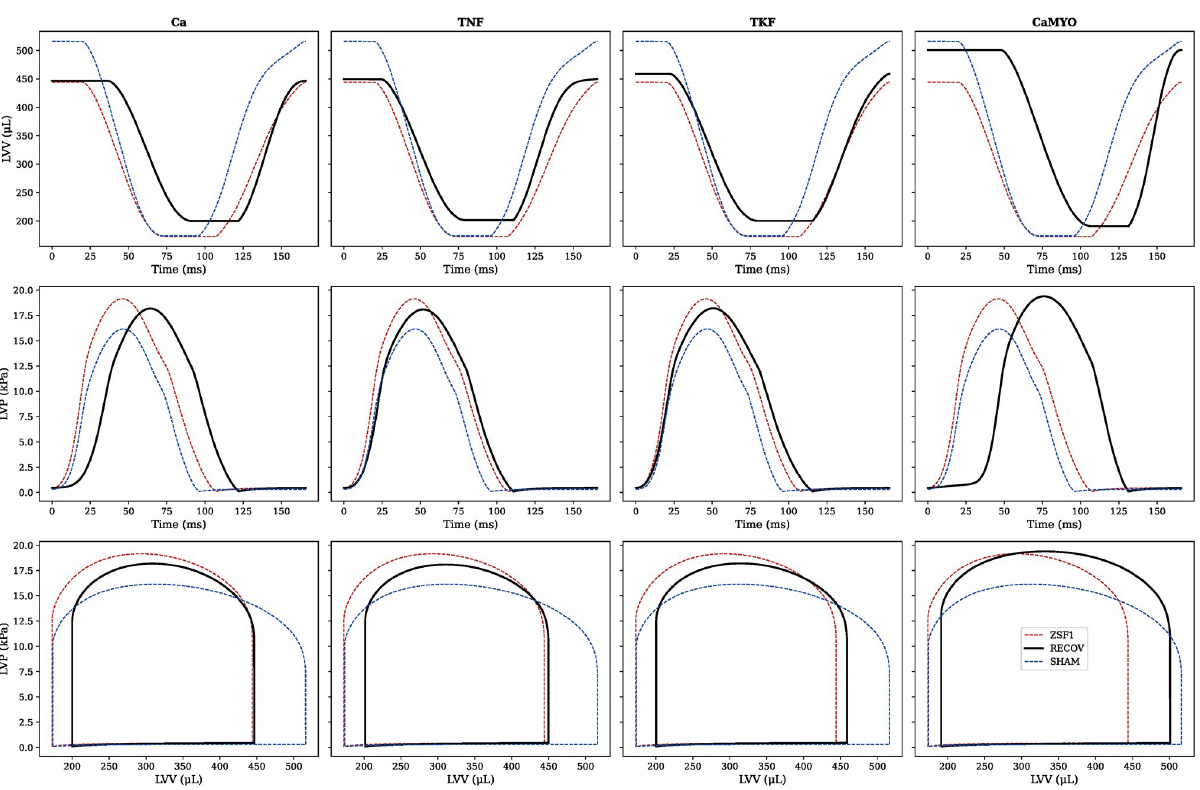
Fig 7. Best fit recovered rat heart models. For each parameter group, the last wave fitted models are compared against the target mean which the history matching aimed to match, and the best-fit model is selected according to the L 2 -norm. This best-fit rat model (RECOV, black thick line) is compared with the reference ZSF1 rat model (red dashed line) and with the reference SHAM rat model (blue dashed line).